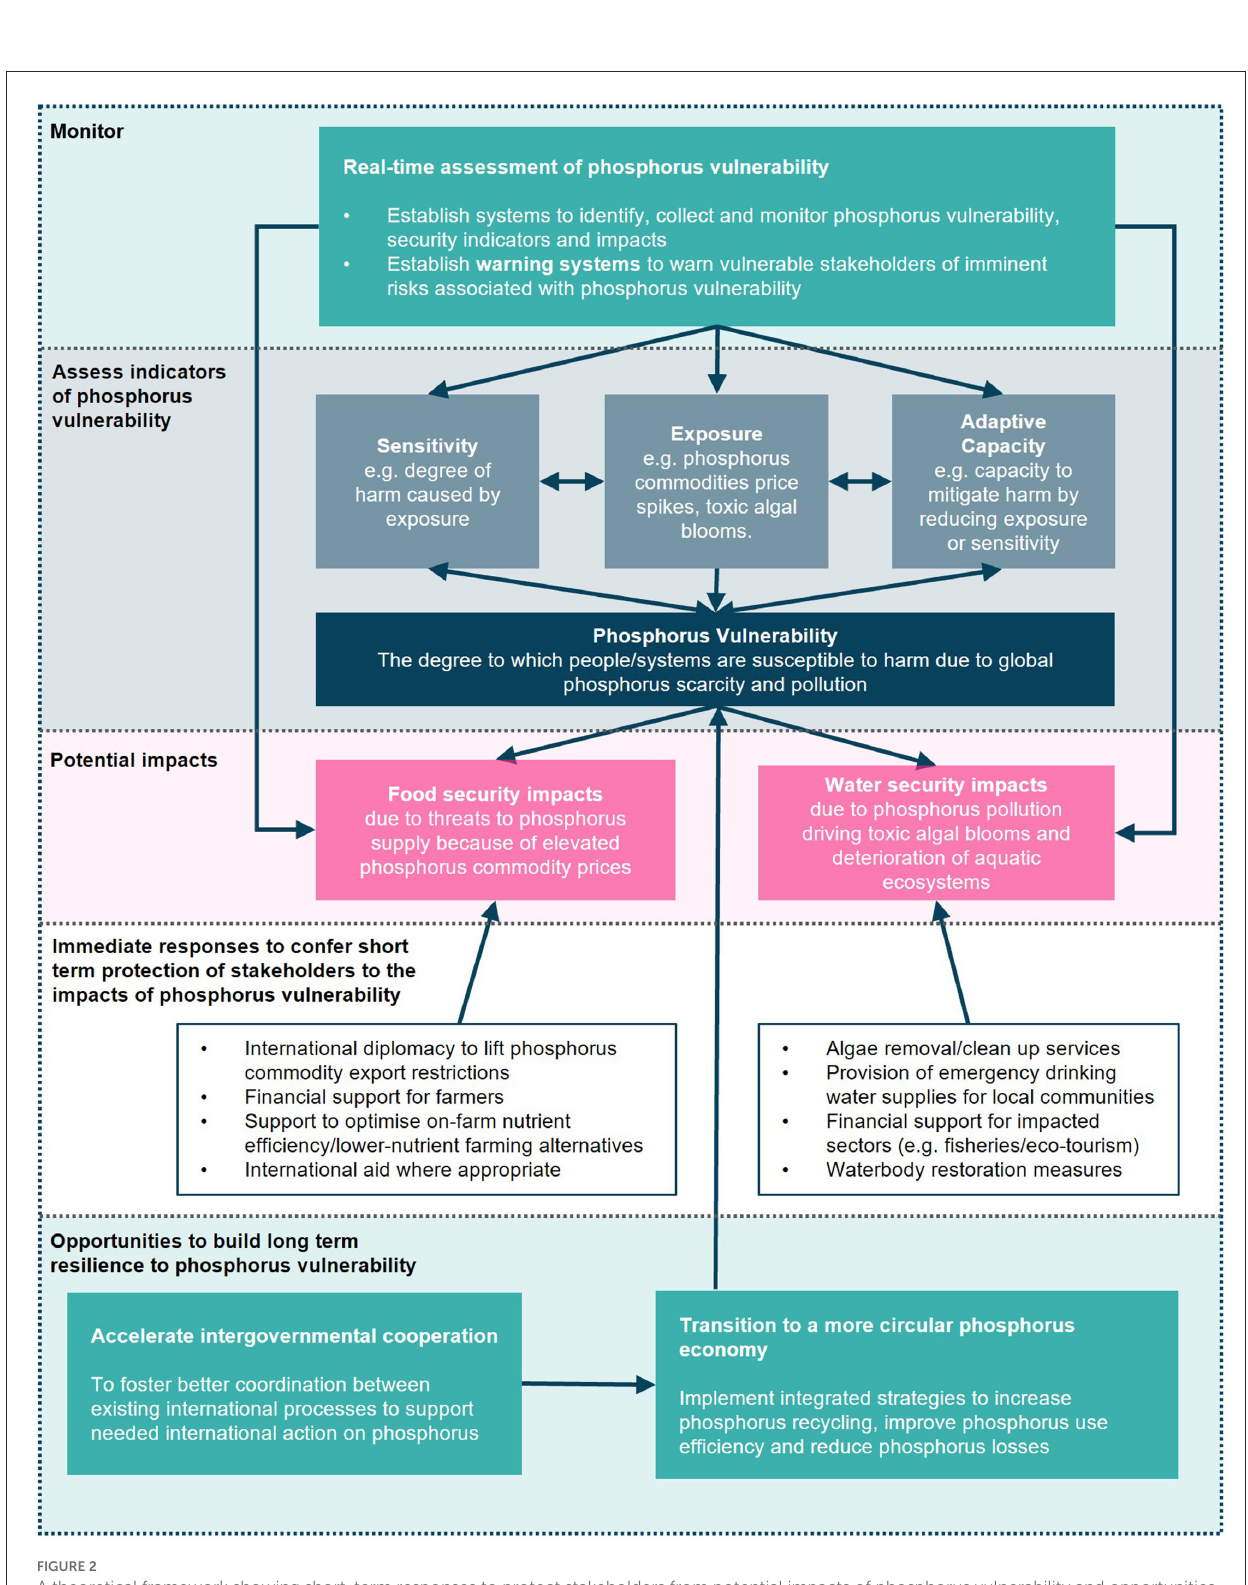
FIGURE2 A theoretical framework showing short-term responses to protect stakeholders from potential impacts of phosphorus vulnerability and opportunities to build resilience to phosphorus vulnerability in the long term.